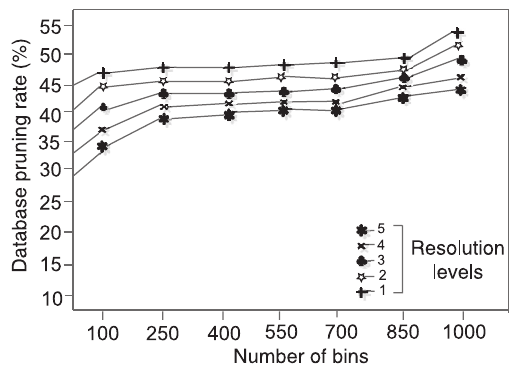
Figure 8. Database Pruning Rate